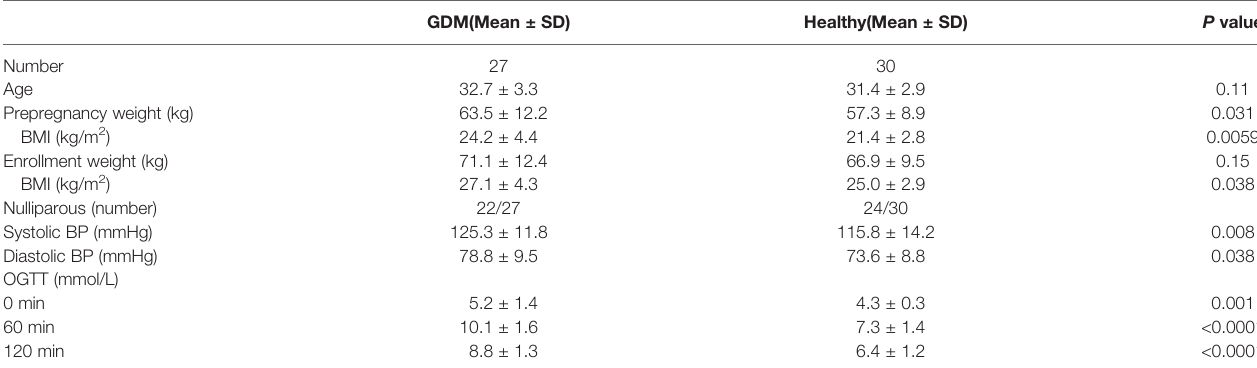
TABLE 1 | The clinical characteristics of all the GDM patients differ from those of the healthy participants.